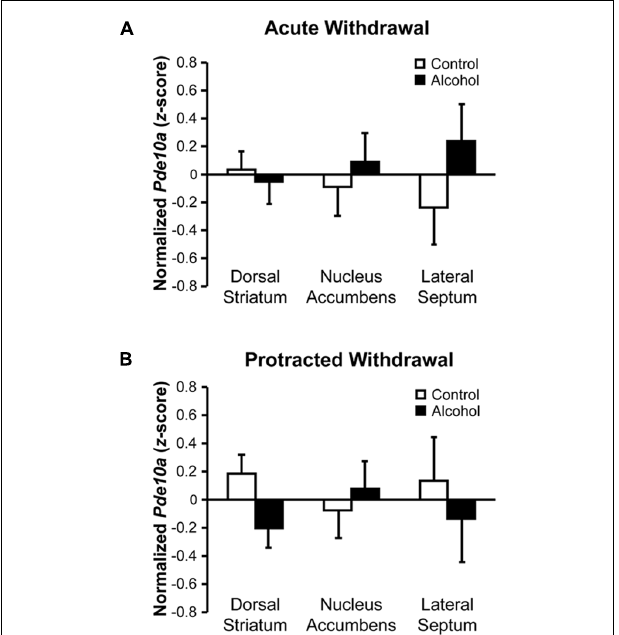
FIGURE 3 |Acute and protracted withdrawal did not significantly alter Pde10a mRNA levels in striatal subregions or the neighboring lateral septum. (A) Pde10a mRNA expression was not significantly modified in rats acutely (8–10 h) withdrawn from intermittent alcohol vapor (black bars), as compared to alcohol-naïve controls (white bars), in the nucleus accumbens, dorsal striatum, or lateral septum. (B) Pde10a mRNA levels remained unaltered in the nucleus accumbens and lateral septum during protracted (6 weeks) alcohol withdrawal, although levels tended to be reduced in the dorsal striatum of alcohol-withdrawn rats. Data are presented as least squares means ± standard error of z -score transformed Pde10a covaried for Cyp expression levels. n = 8–12 per group.